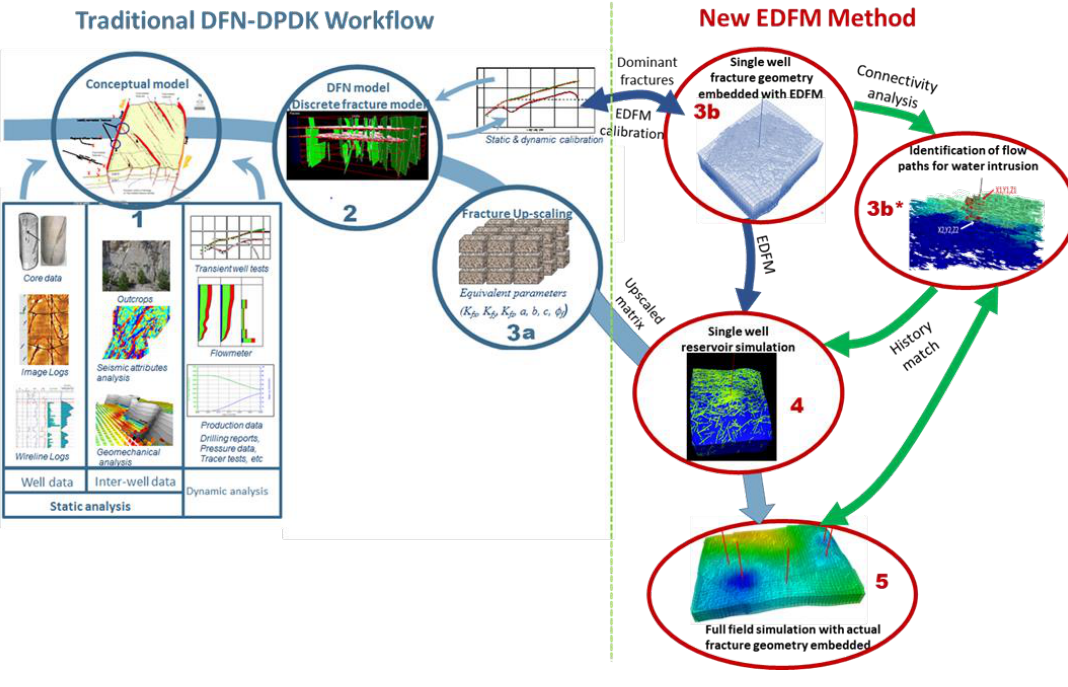
Figure 1. Complete workflow for characterizing water intrusion in a naturally fractured reservoir. Blue circles 1, 2, and 3a refer to conventional discrete fracture network (DFN) generation and upscaling its properties into the matrix [34]. Red circles were implemented (3b, 3b*, 4, 5) and denote the features of applying embedded discrete fracture model (EDFM) method to model dominant fractures in the reservoir explicitly. Green arrows highlight the involved process in water intrusion characterization specifically.